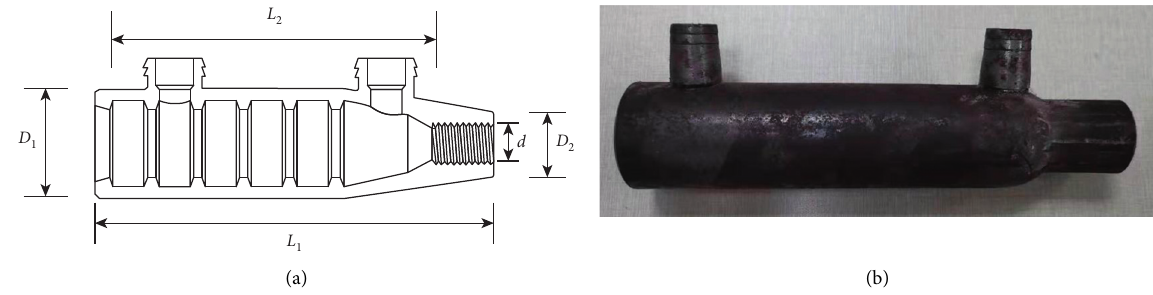
Figure 2: Simplified diagram of the grouted sleeve. (a) Details of the grouted sleeve. (b) A grouted sleeve